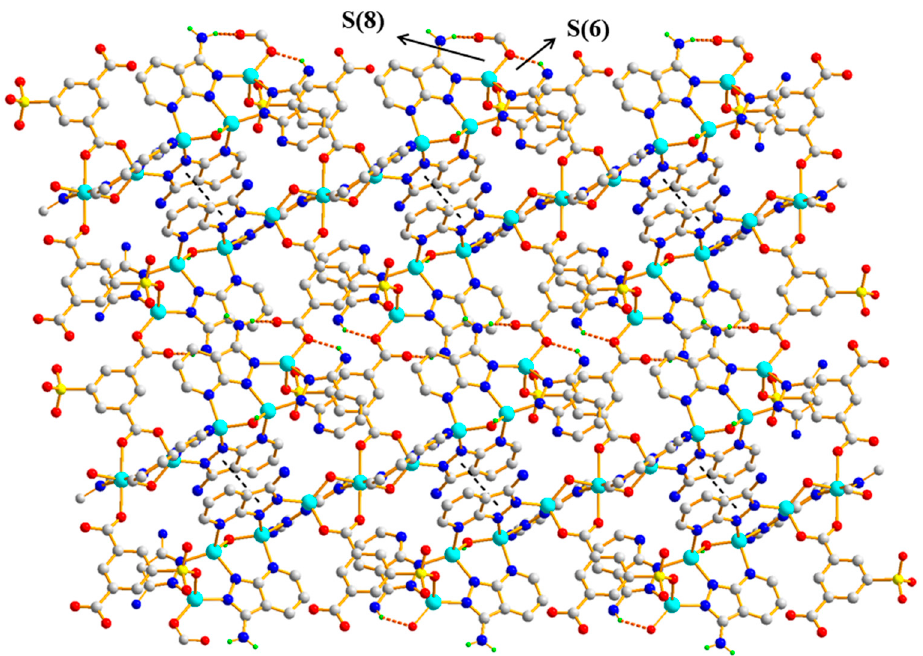
Figure 12. The 2D packing diagram of Polymer 3 constructed by the {Zn 9 } units. The brown dotted lines depict the hydrogen-bonding interactions.